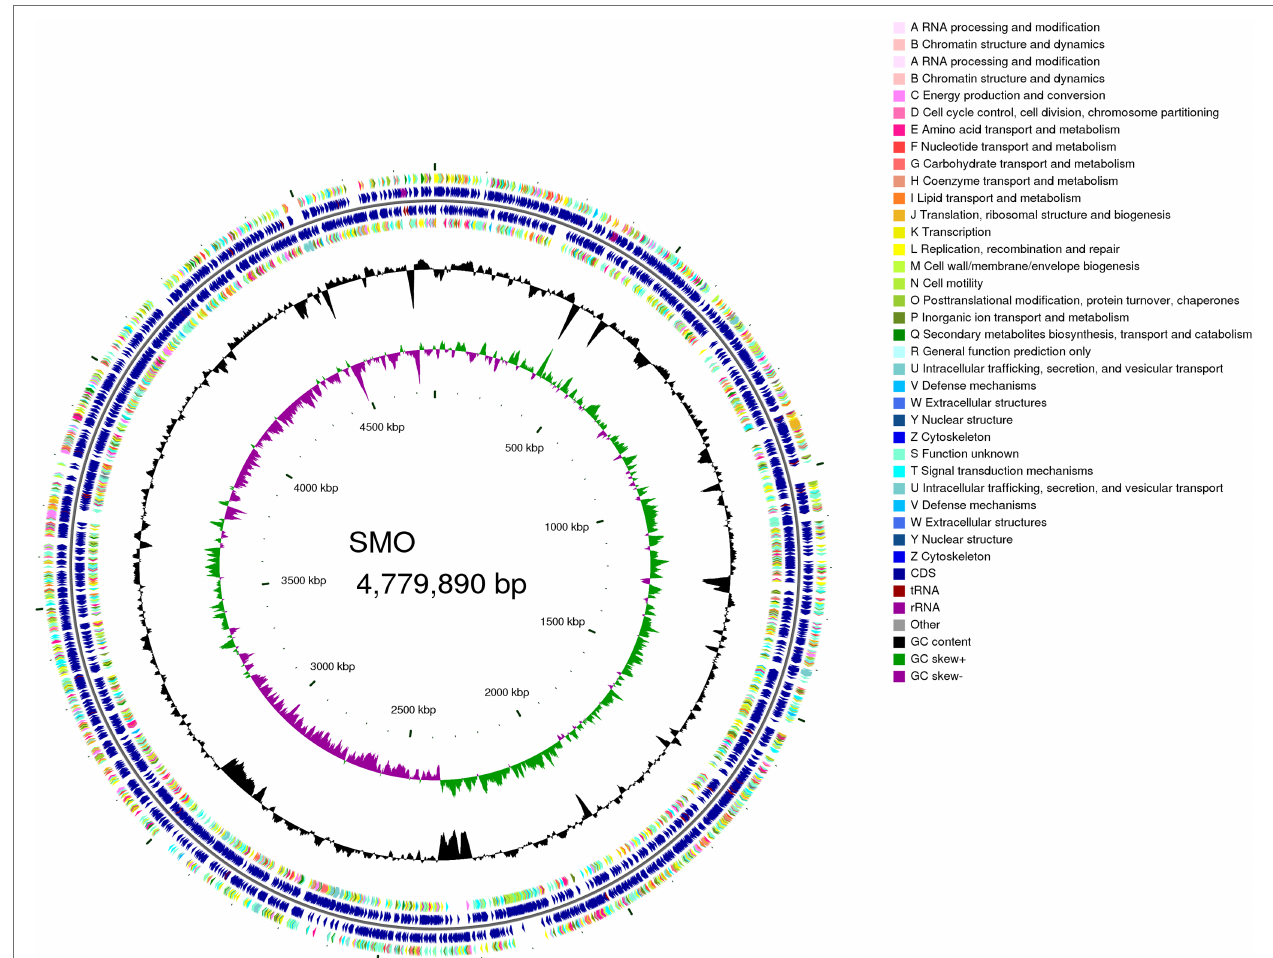
FIGURE 6 | Genome map of SMO. From outer to inner circle: CDS on the positive-strand, different colors indicate different Clusters of Orthologous Groups (COG) function classifications (ring 1), CDS, transfer RNA (tRNA), ribosome RNA (rRNA) on the positive-strand (ring 2), CDS, tRNA, and rRNA on the negative-strand (ring 3), CDS on the negative-strand, different colors indicate different COG function classifications (ring 4), GC content (ring 5), GC-Skew (ring